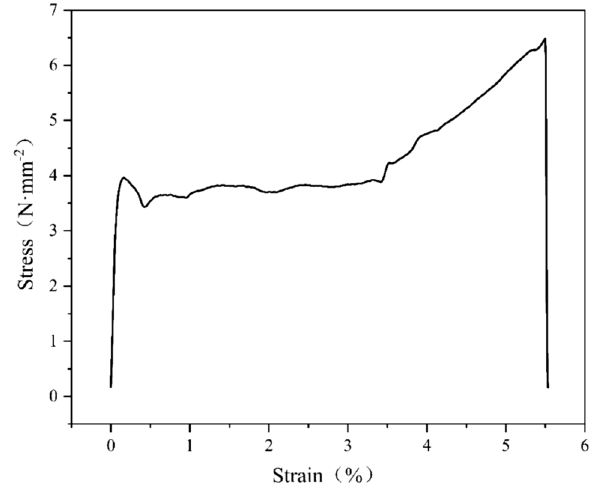
Fig. 4 PE/PA stress–strain